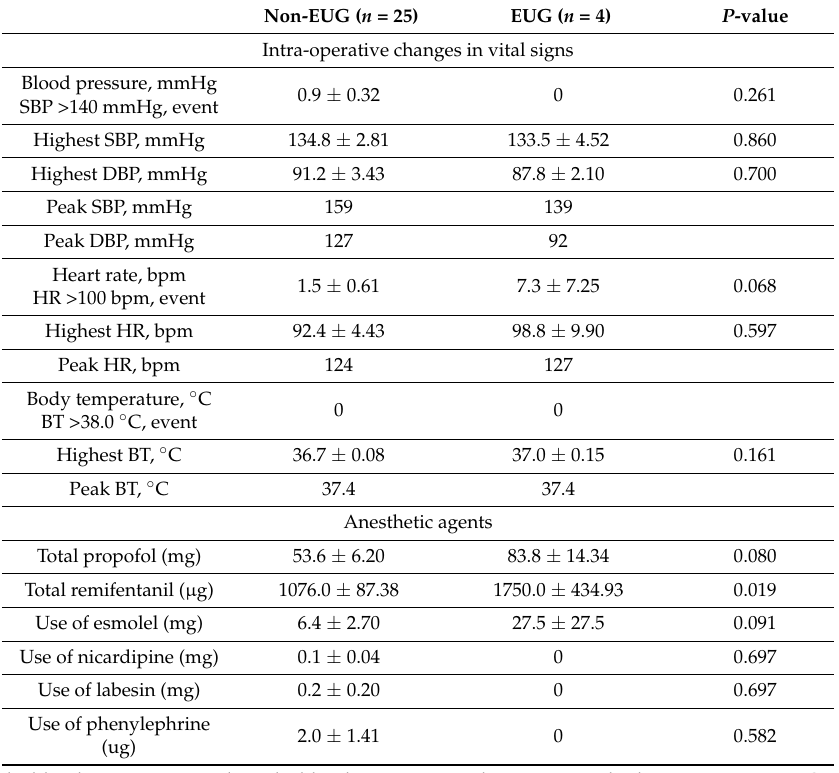
Table 4. Intra-operative changes in vital signs and use of anesthetic agents in patients with extremely uncontrolled and non-extremely uncontrolled Graves’